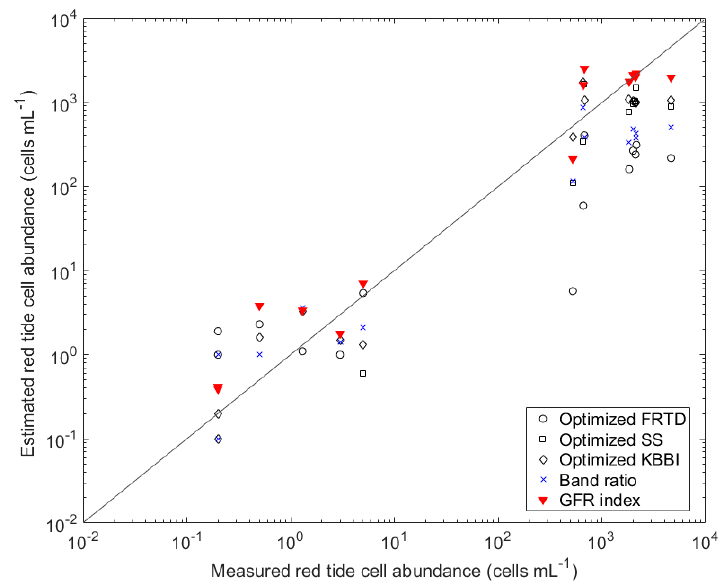
Figure 9. Comparison of M. polykrikoides cell abundances for 14 data pairs derived using five indexes. Table 5. Performance of red tide indexes applied to atmospherically corrected HSI R rs .